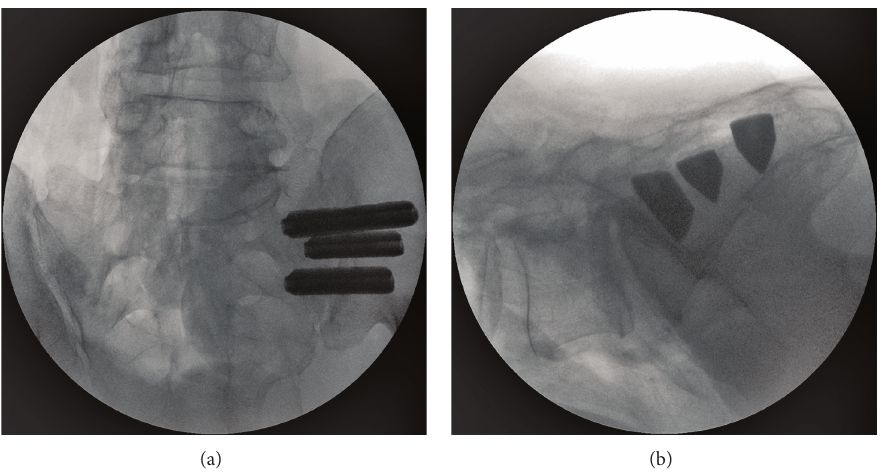
Figure 1: (a) AP and (b) lateral view of all three implants in place.